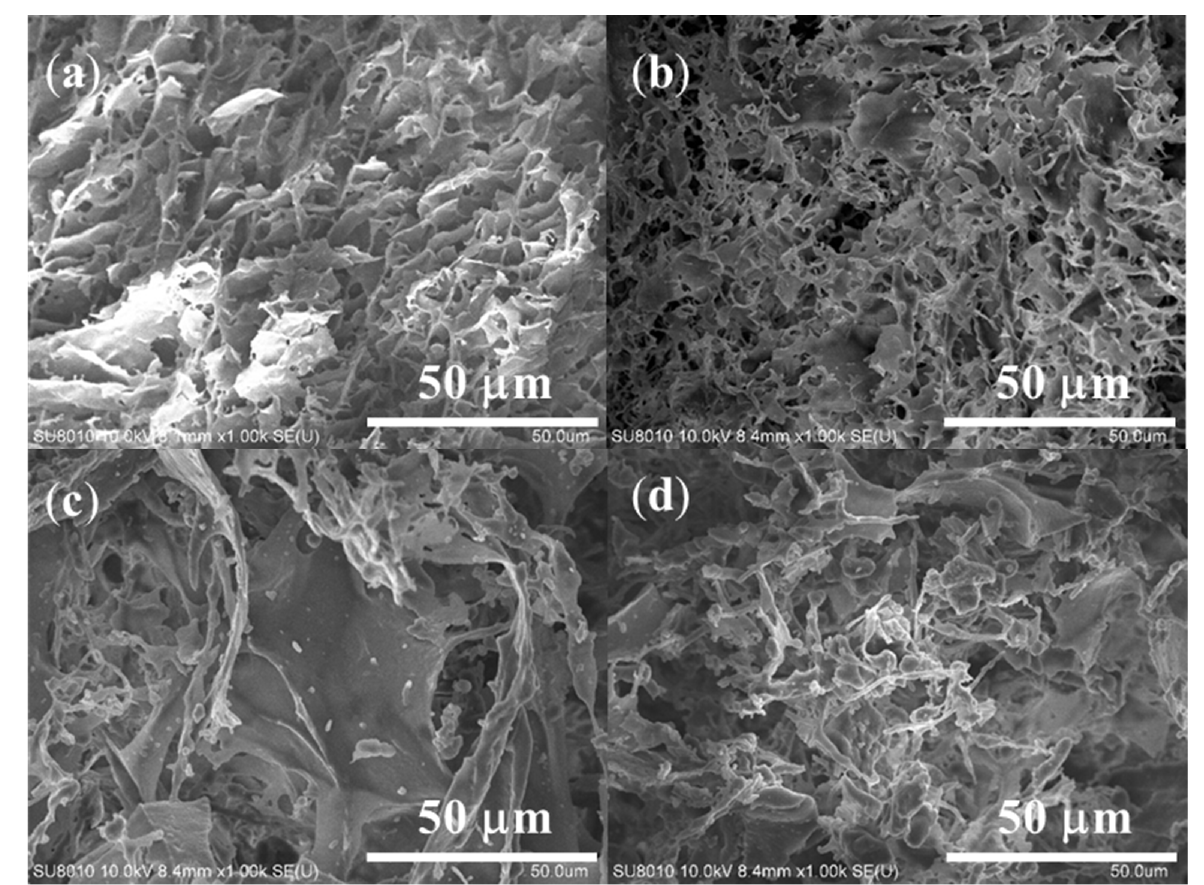
Figure 2. FE-SEM images of lyophilized ( a )12s-PLL 12 - g -Indo 0.10 , ( b ) 12s-PLL 12 - g -Phenyl 0.08 , ( c ) 24s-PLL 12 - g -Indo 0.11 and ( d ) 24s-PLL 12 - g -Phenyl 0.13 samples. The polypeptide concentrations of 12-armed and 24-armed polypeptides were 8.0 wt% and 5.0 wt%, respectively.